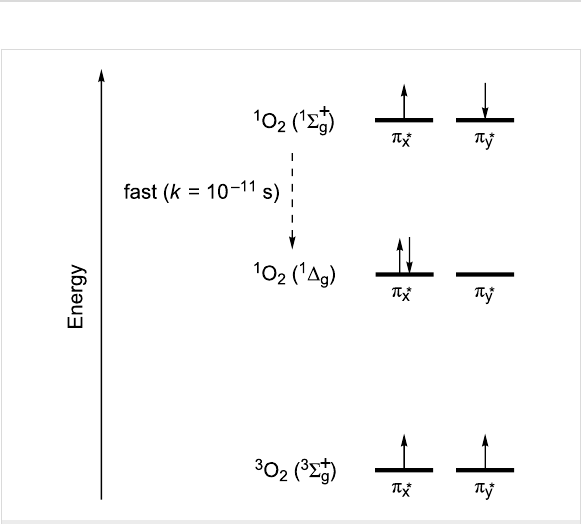
Figure 4: Electronic configurations of the species of oxygen. Adapted from